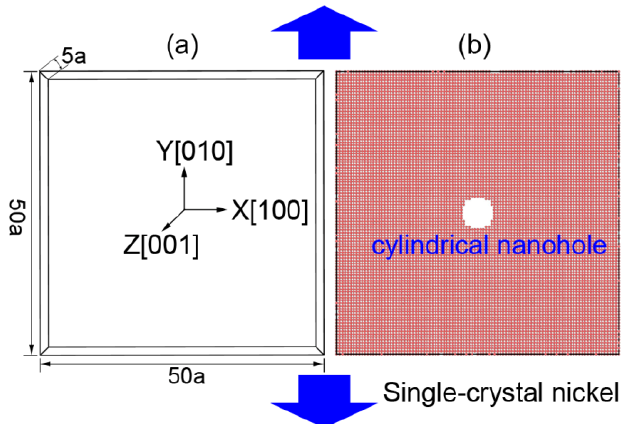
Figure 1. The MD model of FCC single-crystal Ni with a central cylindrical nanohole: ( a ) the size and orientation of simulated region and ( b ) single-crystal Ni with cylindrical nanohole.